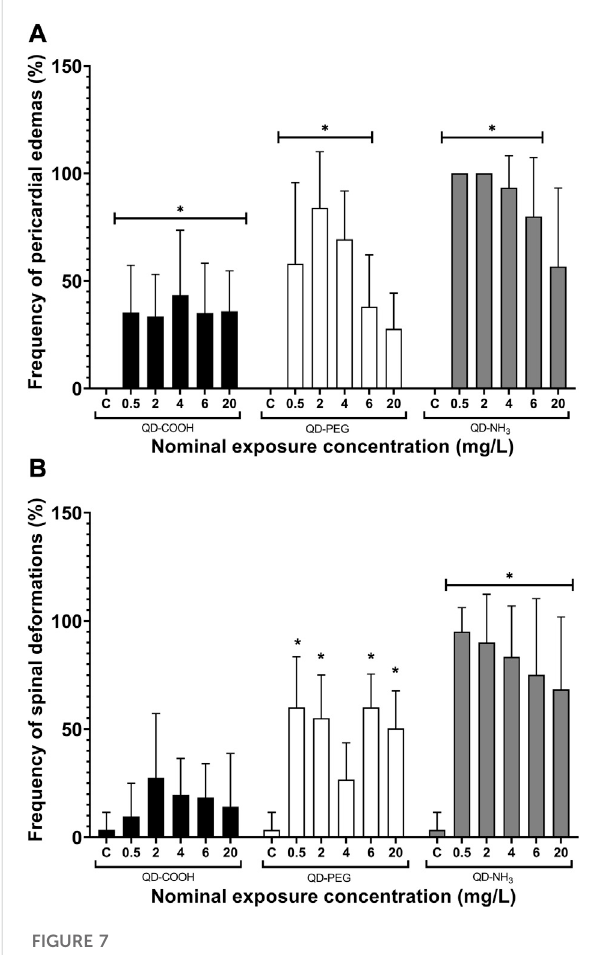
FIGURE 7 Spinal deformations (A) and pericardial edemas (B) of Danio rerio embryosexposedtoQD-COOH,QD-PEG,andQD-NH 3 expressedas a percentage of surviving embryos. Error bars represent standard deviation. Single asterisk (*) denotes signi fi cant differences from control ( p < 0.05, T -tests).